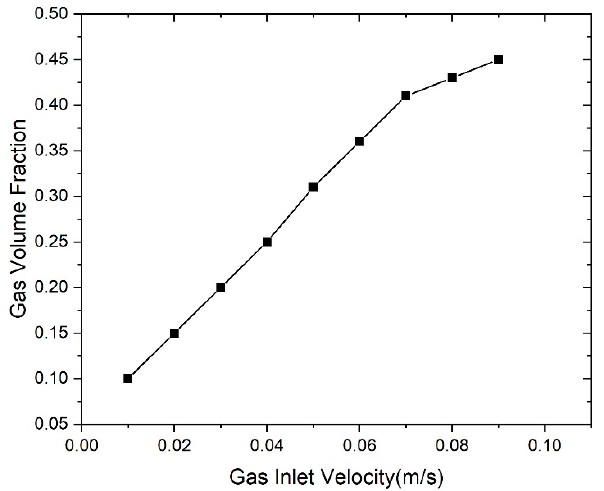
Figure 5. Gas volume fraction distribution contour under condition 3 (t = 7 s).